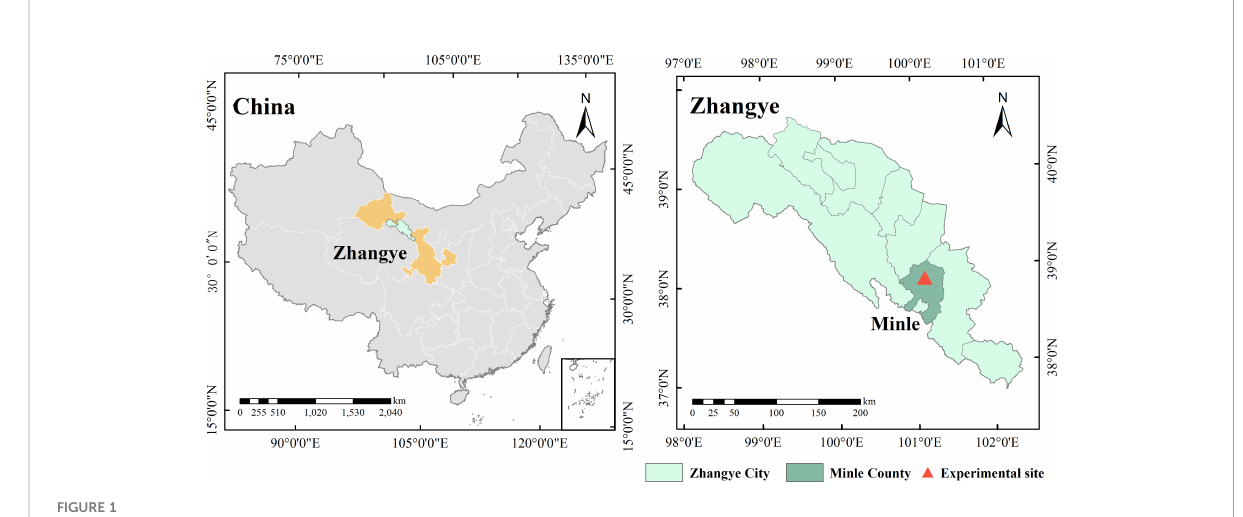
FIGURE 1 Location of fi eld experiments (Minle,